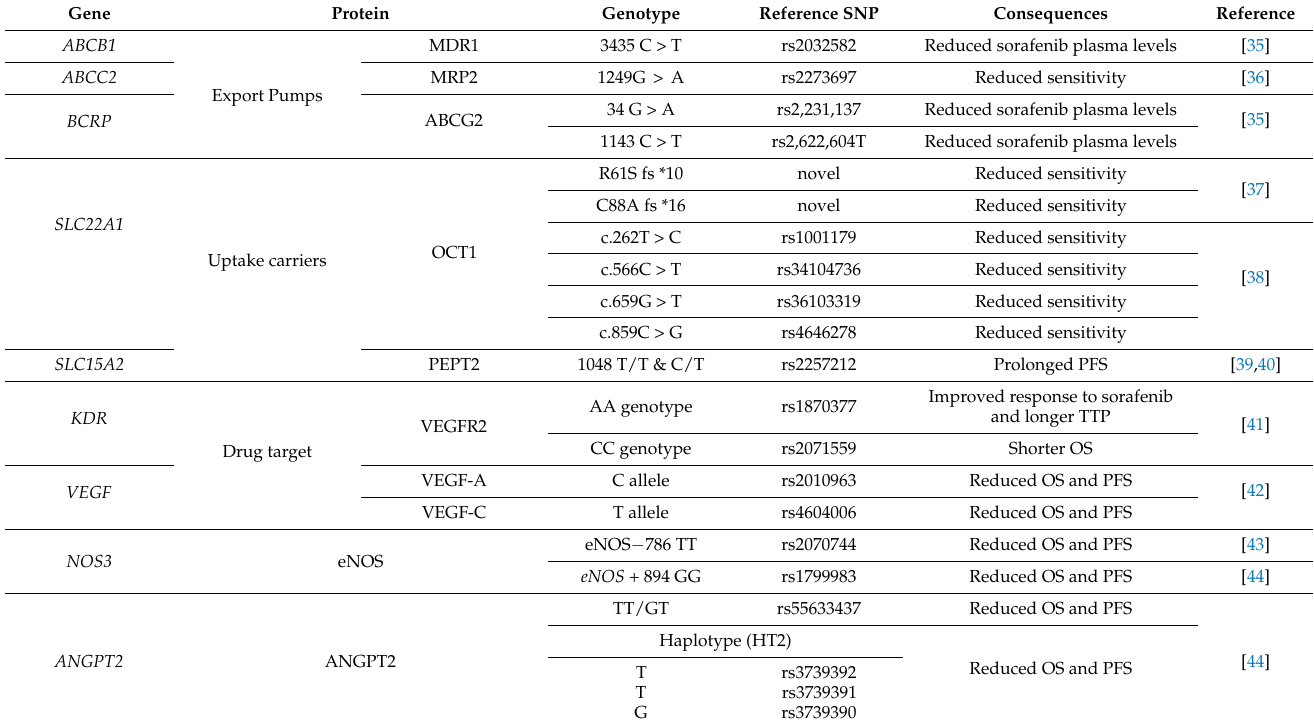
gene ( ANGPT-2 ) and Nitric oxide synthase-3 gene ( NOS-3 ). Table 1. Genetic polymorphisms in HCC and their impact on sorafenib efficacy.